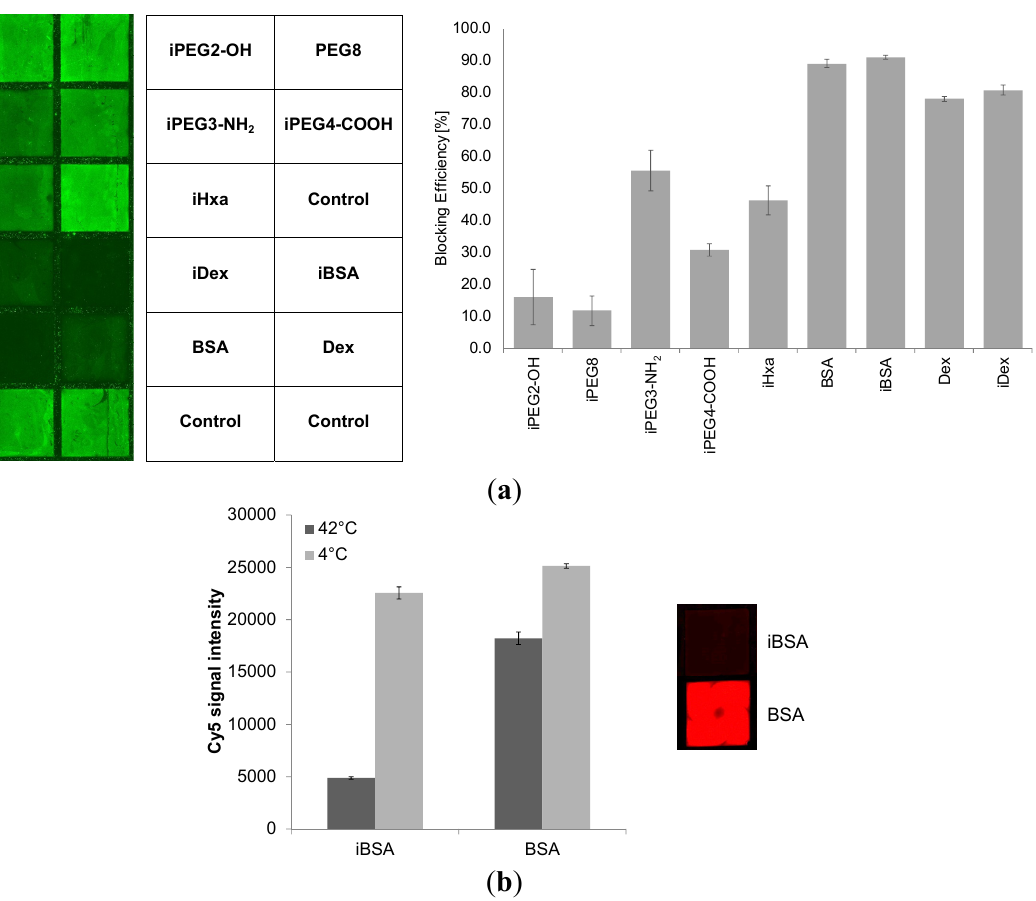
Figure 7. ( a ) Comparison of blocking efficiency of immobilized azide derivatives at concentrations of 100 µM for the different PEG-azide reagents and 10 µM for dextran, azide-modified dextran, BSA and azide-modified BSA tested against Cy3-labeled goat anti-rabbit IgG. The non-specific binding (NSB) is made visible as green squares. Blocking efficiency is given as percentage [%] of signal reduction of control wells that have ADIBO-functionalized slides surfaces. Data are mean values ± SD of hexaplicate experiments. Fluorescence signal intensities across control wells were 2,680 ± 165 and across iBSA wells 230 ± 22. ( b ) Comparison between physically adsorbed and covalently attached BSA. The use of azide-modified BSA allows nearly complete capping of the free to penetrate the layer ADIBO groups. Physically adsorbed BSA cannot prevent Cy3-N 3 and react with the ADIBO groups as visualized with the red squared well. Higher temperatures increase the coupling rates of BSA-N and also appear to slightly improve 3 permeability. Data are mean surface adsorption of unmodified BSA to decrease Cy5-N 3 values ± SD of quadruplicate